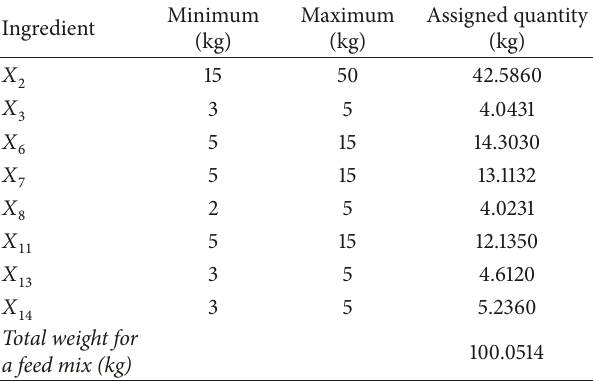
Table 6: A sample solution obtained from the EA-PH